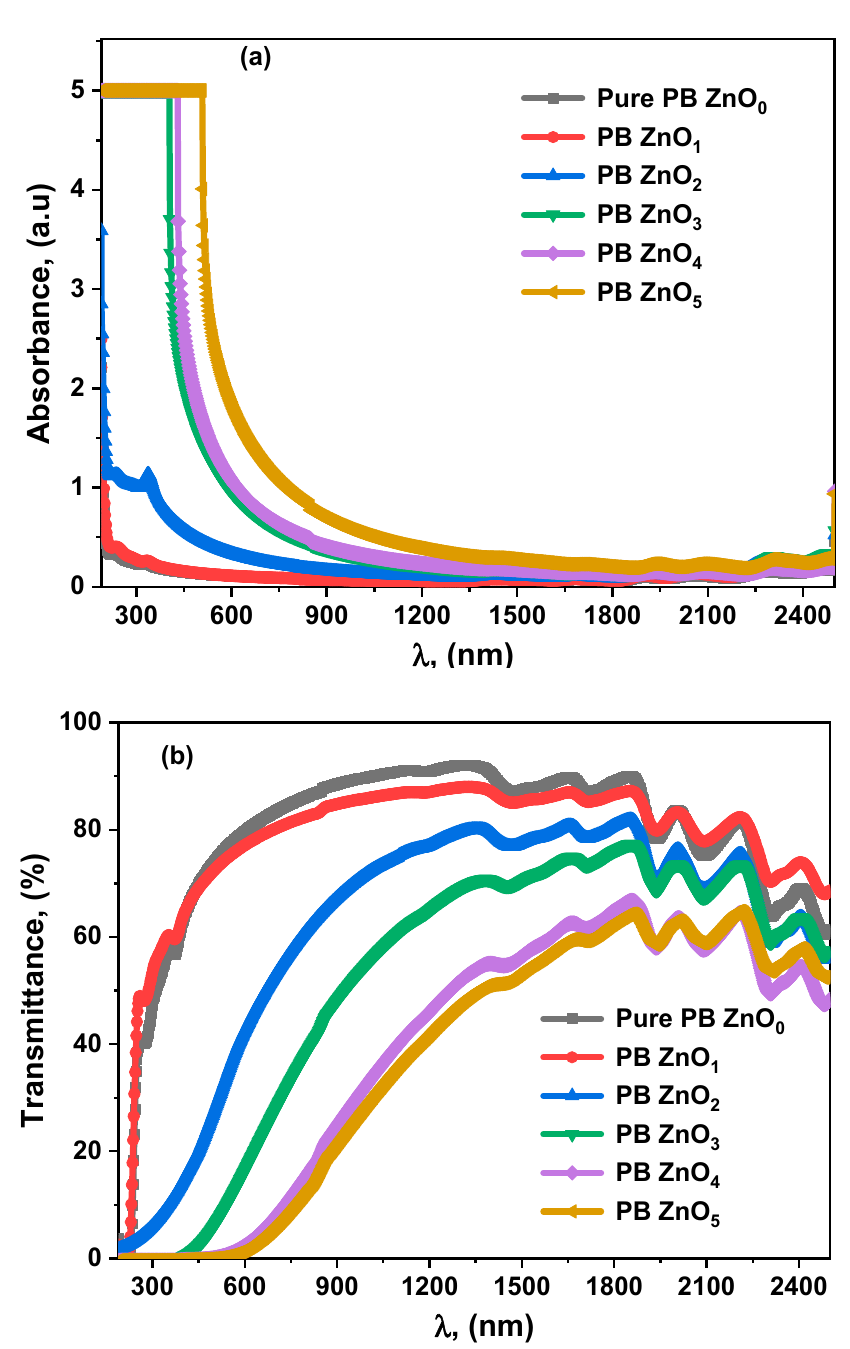
Figure 3. ( a , b ): Optical UV-Vis-NIR ( a ) Absorbance and ( b ) Transmittance curves of (PVA-PVP) blend and ZnO polymeric nanocomposite films.